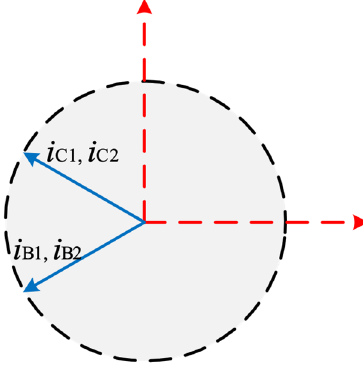
Figure 14. Phase diagram of regulated currents under two-phase open-circuit (Case I: phase A1 and A2 open-circuit) fault-tolerant control.